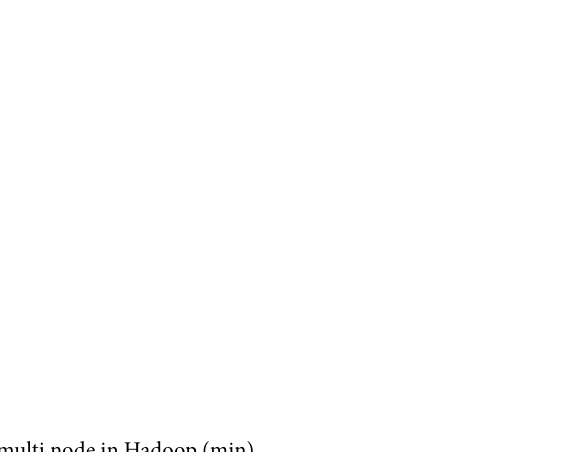
Figure 8. The running time of three algorithms in a single node with different ρ size on: ( a ) ca-HepTh dataset, and ( b ) ego-Facebook dataset.